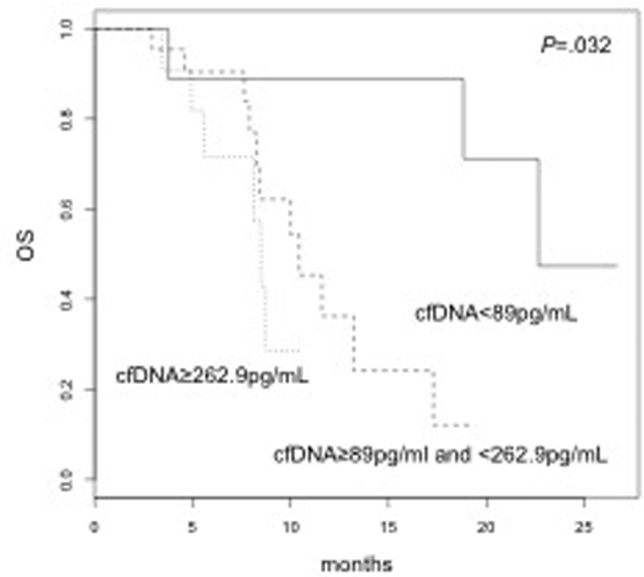
Determining operational limits for cfDNA concentration and cfDNA shedding. (A, B) Receiver Operating Curve (ROC) was used to identify the best cut-off to discriminate the worse prognosis (overall survival less than one year) patients for baseline plasma cfDNA concentration (A) and cfDNA shedding coefficient (B).